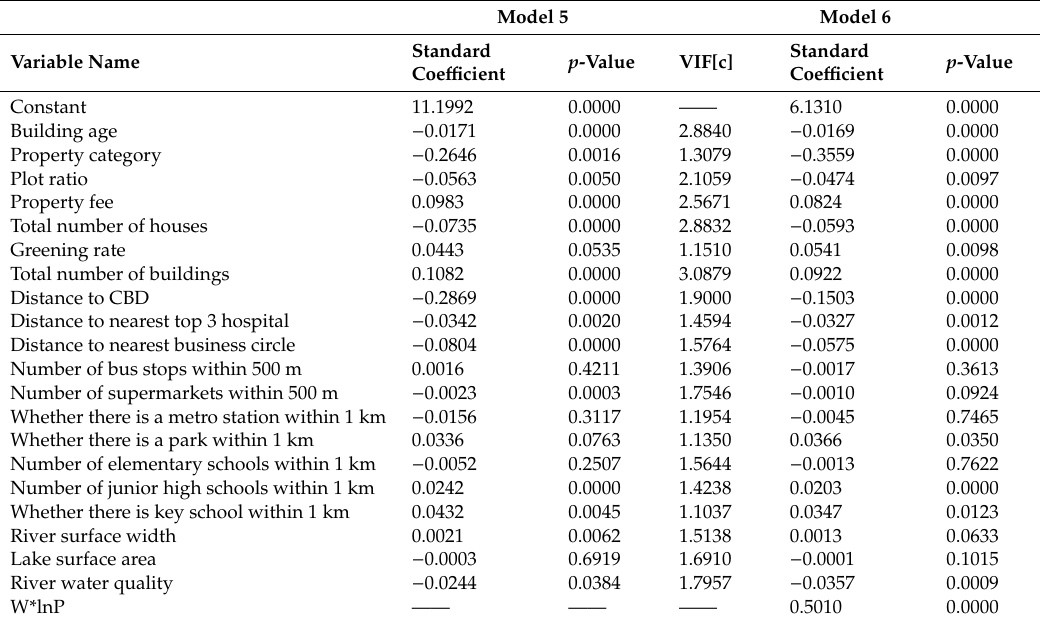
Table 7. Regression results of Models 5 and